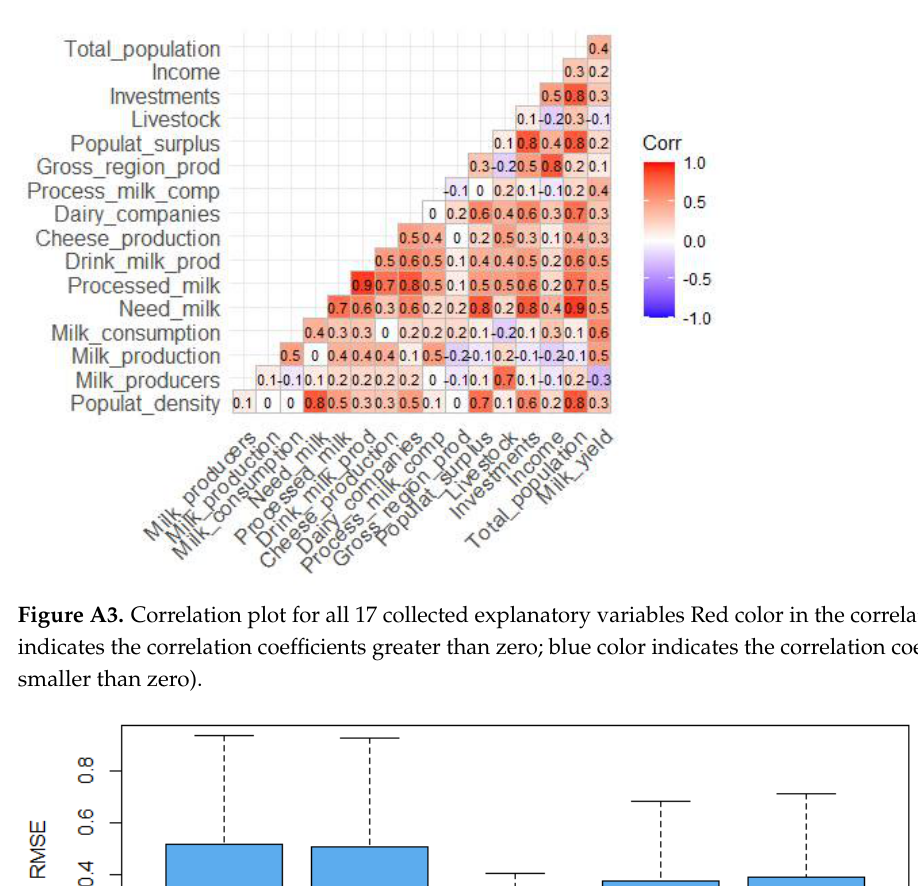
Figure A2. Boxplots for milk prices without outliers (2015–2019).